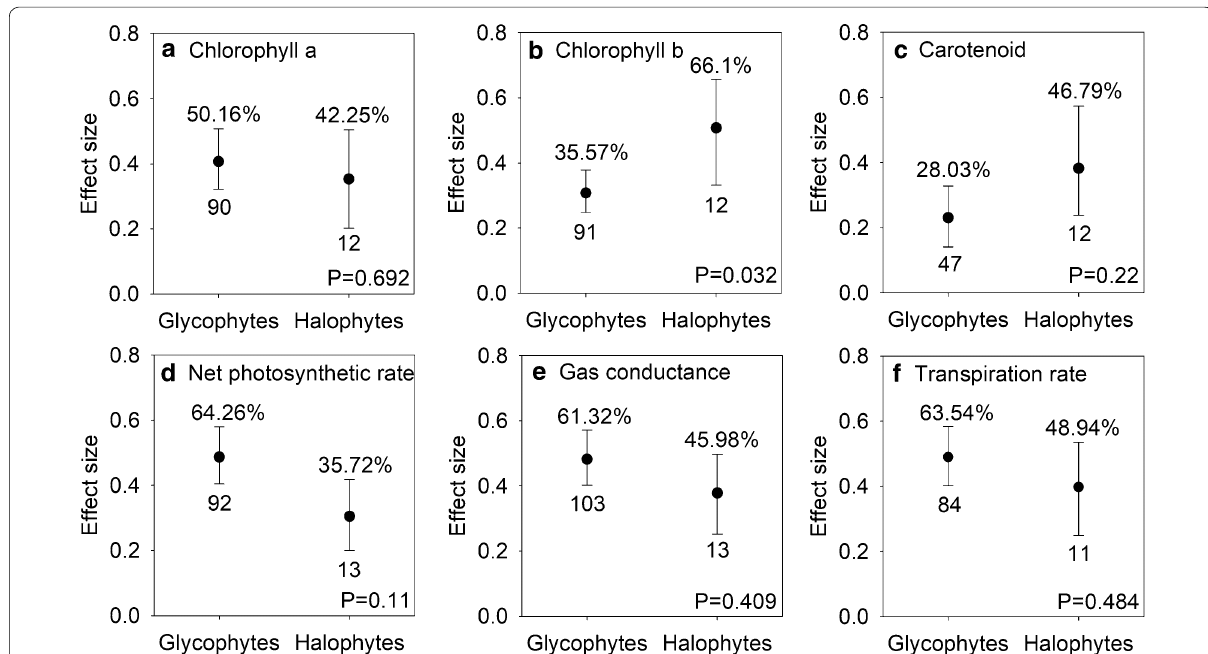
Fig. 5 Responses to salt stress of chlorophyll a ( a ), chlorophyll b ( b ), carotenoid ( c ), net photosynthetic rate (d), stomatal conductance ( e ), and transpiration rate ( f ) in mycorrhizal halophytes and mycorrhizal glycophytes. Error bars represent 95% confidence intervals (CIs). Back-transformed effect sizes are shown above the bars. The numbers of studies are shown under the bars. Inoculation effects were considered significant when the 95% CIs did not overlap with zero. The P values for each panel reflect the significant differences between halophytes and glycophytes